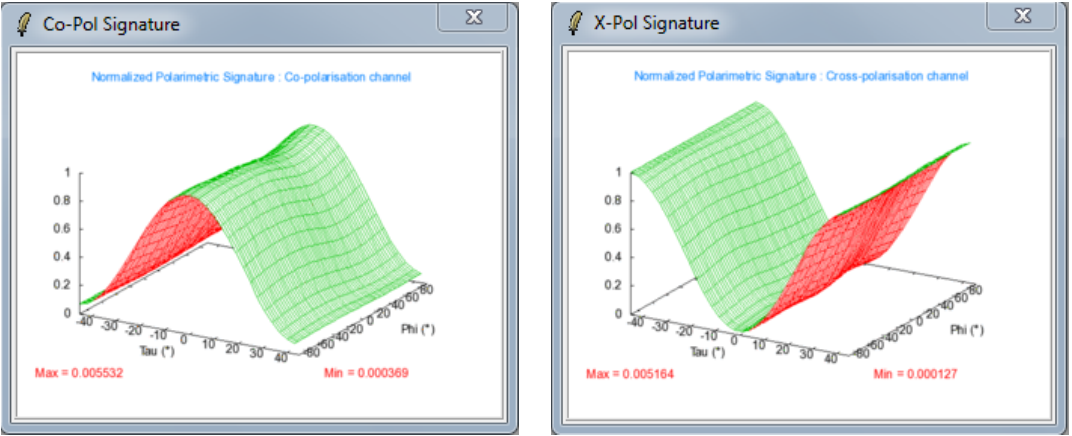
Figure 8. (d) Radar penetrated areas polarimetric